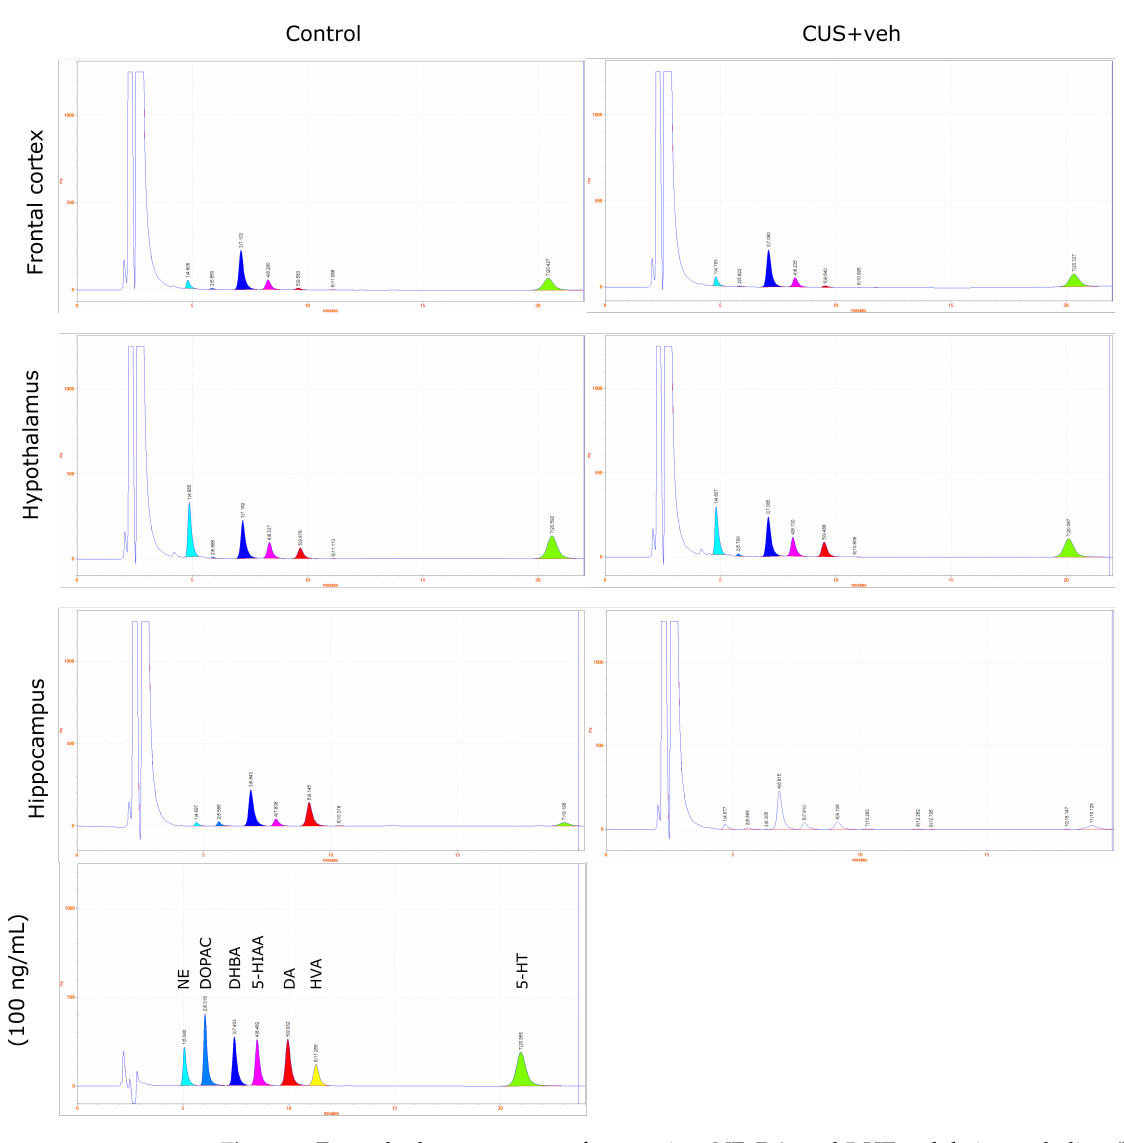
Figure 8. Example chromatograms of monamines NE, DA, and 5-HT and their metabolites (DOPAC, 5-HIAA, and HVA) extracted from the frontal cortex, hypothalamus, and hippocampus after CUS exposure and vehicle